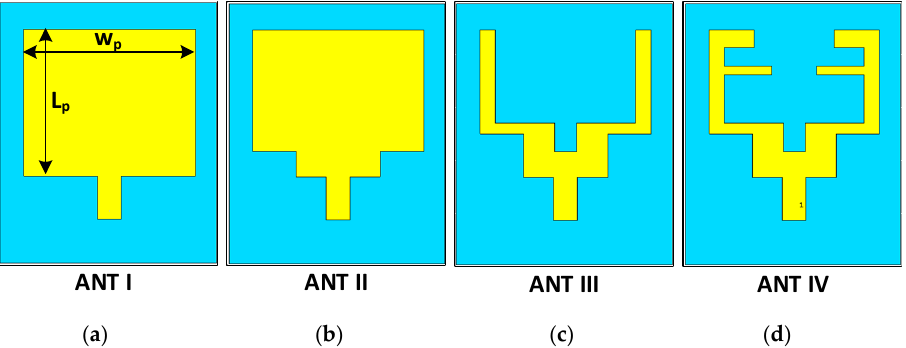
Figure 3. Design steps of the proposed triband antenna: ( a ) ANT I (patch only), ( b ) ANT II (Truncated patch), ( c ) ANT III (U-shaped patch), and ( d ) ANT IV (proposed antenna).